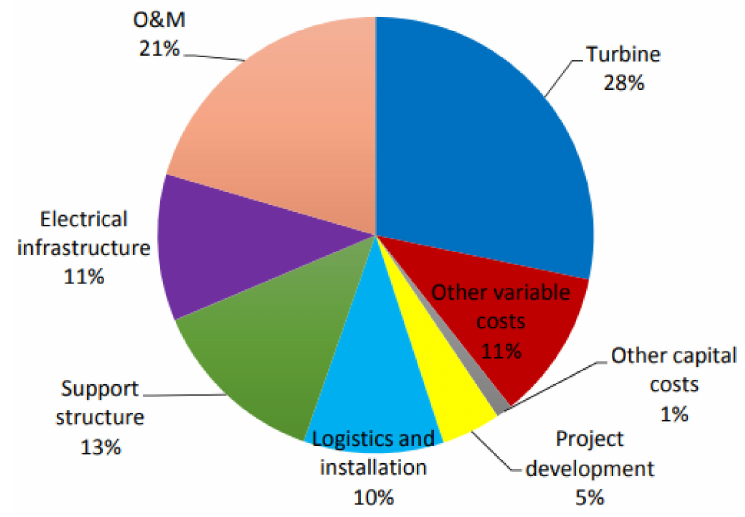
Figure 1. Cost Distribution of an Offshore Wind Turbine [5].